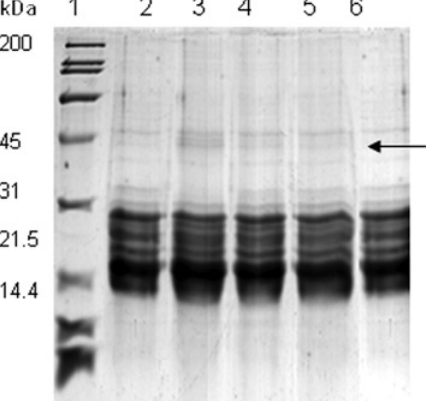
Figure 4: Chaperone activity of α -crystallin as assessed by the sup- pression of heat-induced aggregation of citrate synthase at 45 ° C in the absence (trace 1) and presence of α -crystallin isolated from the lenses injected with vehicle (trace 2), ADan-red (trace 3), ADan-oxi (trace 4), A β 1-40 (trace 5), and A β 1-42 (trace 6). The traces are the average of four samples in each